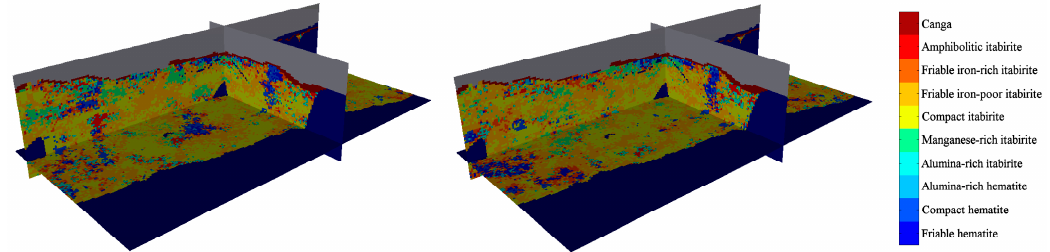
Figure 6. Isometric view of two realisations of the classified rock type ( left : realisation 1 and right : realisation 2), showing the plan view and vertical cross-sections passing through the origin (local coordinate system). Waste and air are shown in dark blue and grey, respectively.